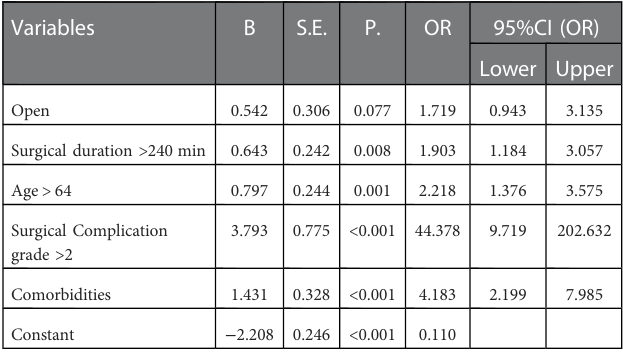
TABLE 6 Multivariable analysis of delayed discharge. Variables B